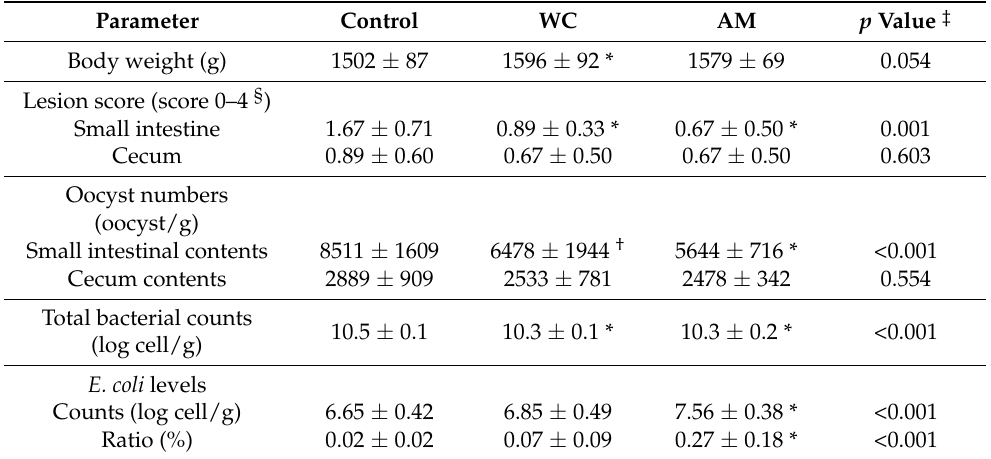
Table 2. The body weights, lesion scores, oocyst numbers, total bacterial counts, E. coli levels, and intestinal lengths of broiler chicks slaughtered at 29 days of age.